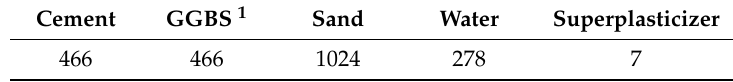
Table 2. Mixture composition of mortar for textile reinforced concrete (TRC) (unit: kg / m 3 ).